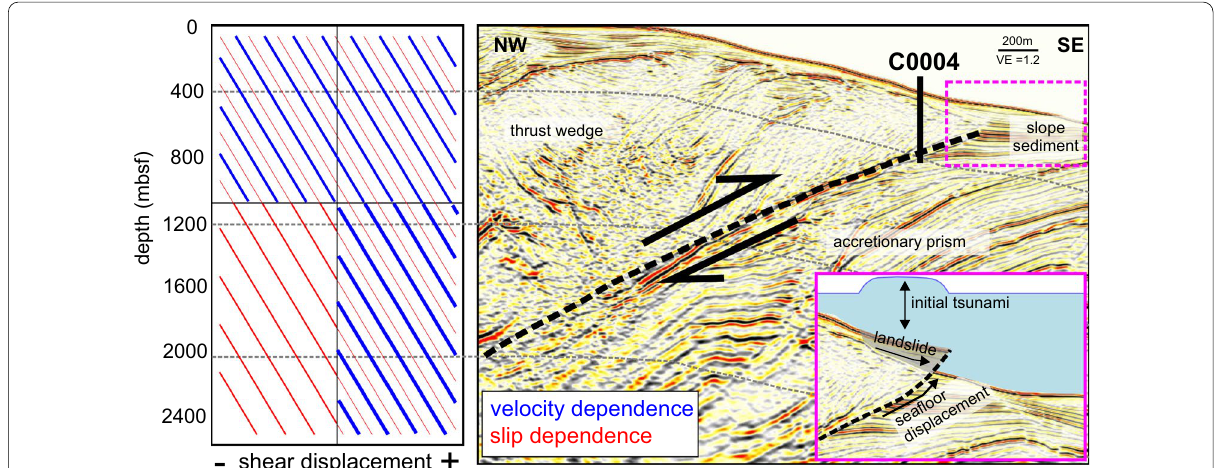
Fig. 7 Friction along the megasplay fault. Seismic cross section of Site C0004 showing how friction slip and velocity dependence is expected to evolve with depth along the megasplay fault. At deeper depths, slip dependence is the mechanism facilitating instability at short displacements, but at larger shear displacement the friction velocity dependence becomes dominant. At shallow depths, the friction velocity dependence is dominant for both short and large shear displacement. Line thicknesses illustrate the relative magnitude of the velocity and slip dependence. Depth is extrapolated from effective normal stress calculations from shipboard bulk density measurements on the cored interval. The overview map is shown in Fig. 1. Inset indicates natural hazards associated with megasplay slip deforming the